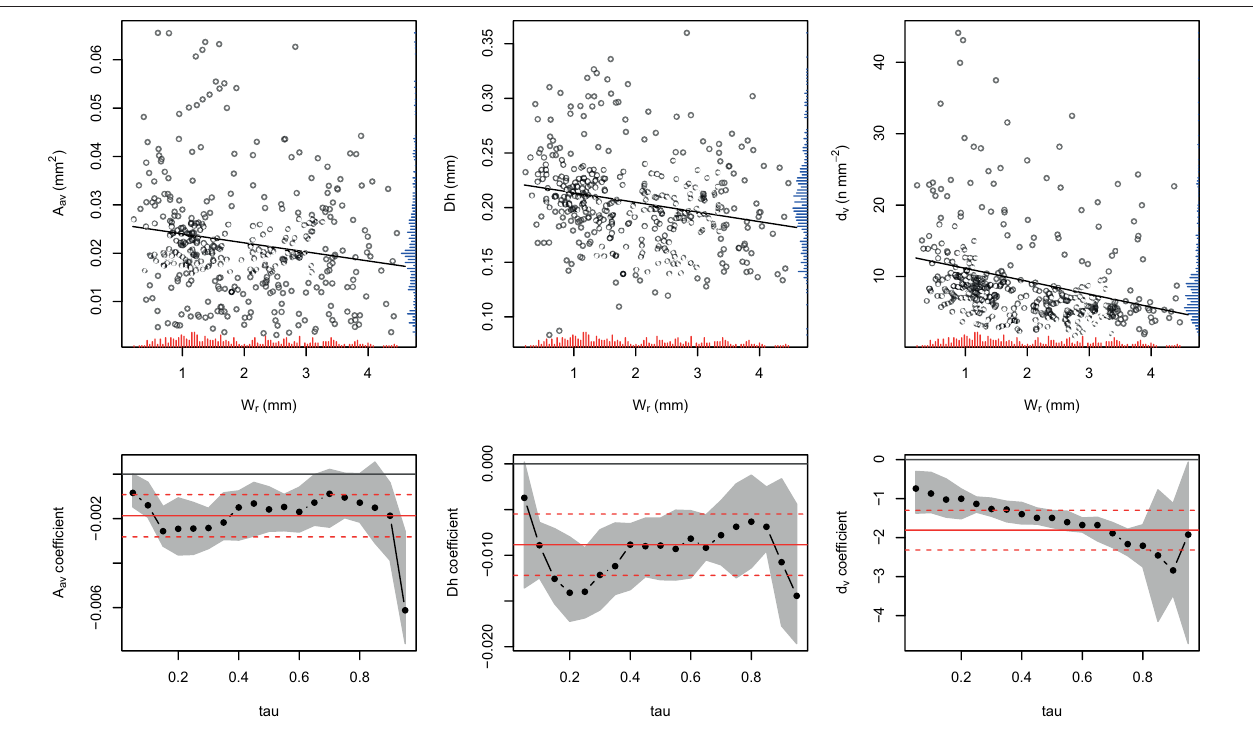
FIGURE 1 | Relationships between the average vessel size [A av ; β = − 0.002, F (1 , 375) = 10.52, p < 0.01], hydraulic diameter [D h ; β = − 0.009, F (1 , 375) = 18.77, p < 0.001], vessel density [d v ; β = − 1.808, F (1 , 375) = 34.12, p < 0.001], and tree-ring width [W r ] (upper panel). Red and blue rugs inside the plots show distribution of the x and y variables, respectively. Slope of the estimated linear quantile regression for the xylem traits as a function of the τ th quantile τ (lower panels). Full red lines are the least squares estimates for the coefficients and the red dashed lines are the 95% confidence intervals for the least squares estimates. The gray area represents the 95% confidence interval (1000 replicate bootstrap) for the quantile regression estimates (full circles, each 5th quantile).